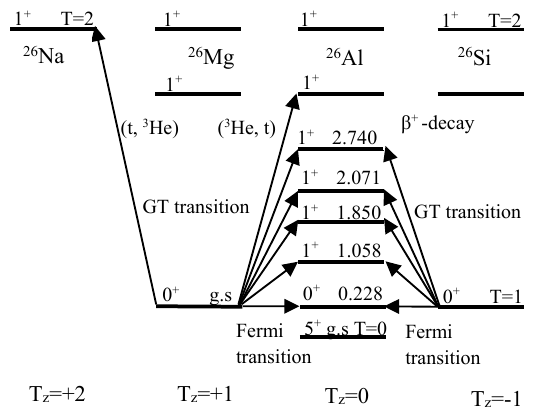
Fig. 1. Schematic view of the isospin analogous states and analogous GT transitions in the A=26, T z =+2, +1, 0 and -1 isobars